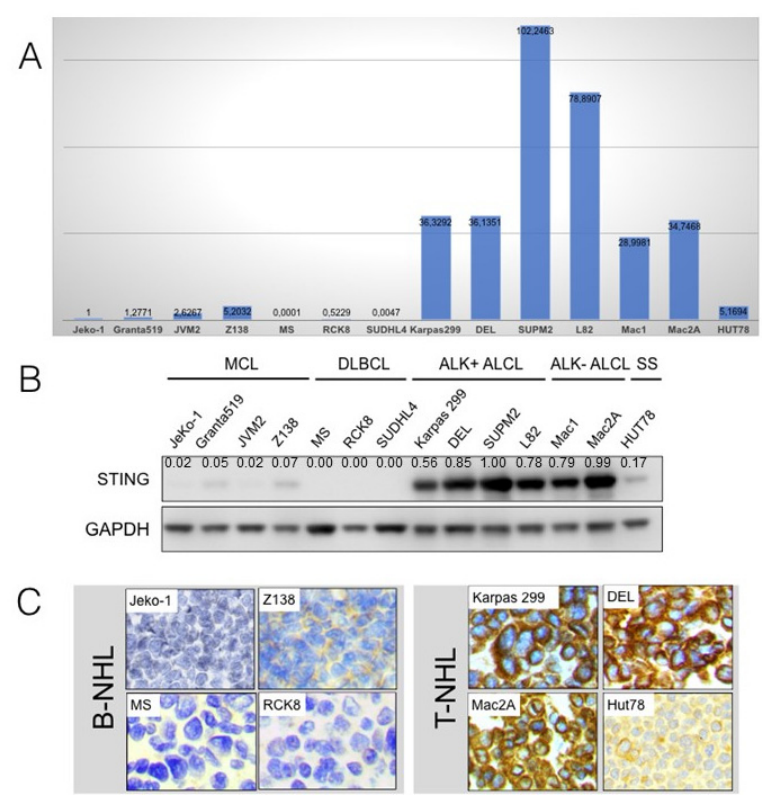
Figure 1. STING gene and protein expression in B- and T-cell non-Hodgkin lymphoma cell lines. ( A ) Real-time quantitative PCR performed on 14 cell lines of various B- and T-cell non-Hodgkin lymphoma (NHL) types showed STING gene expression in T-cell but not in B-cell